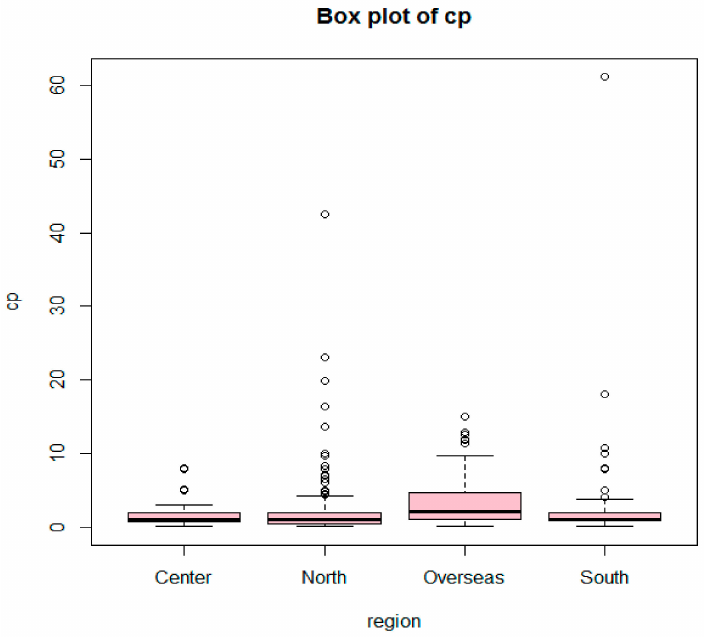
Figure A3. Relative productivity distribution by